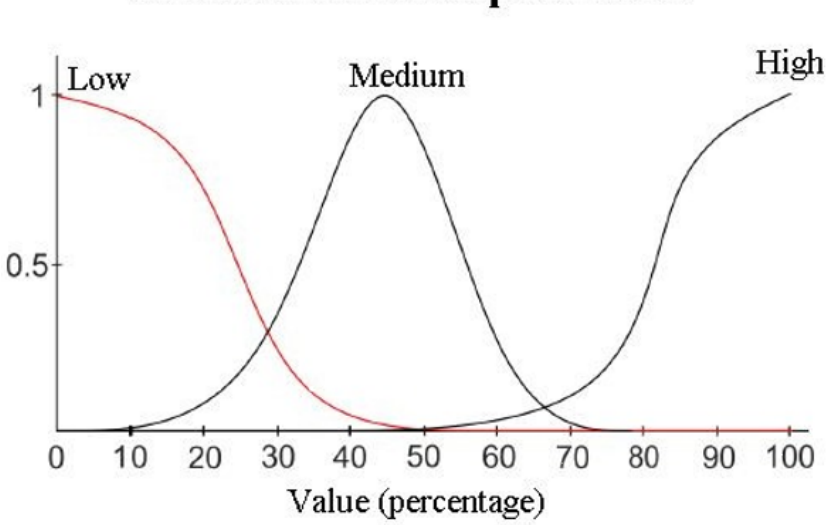
Figure 9. Really Simple Syndication ( RSS) membership function.